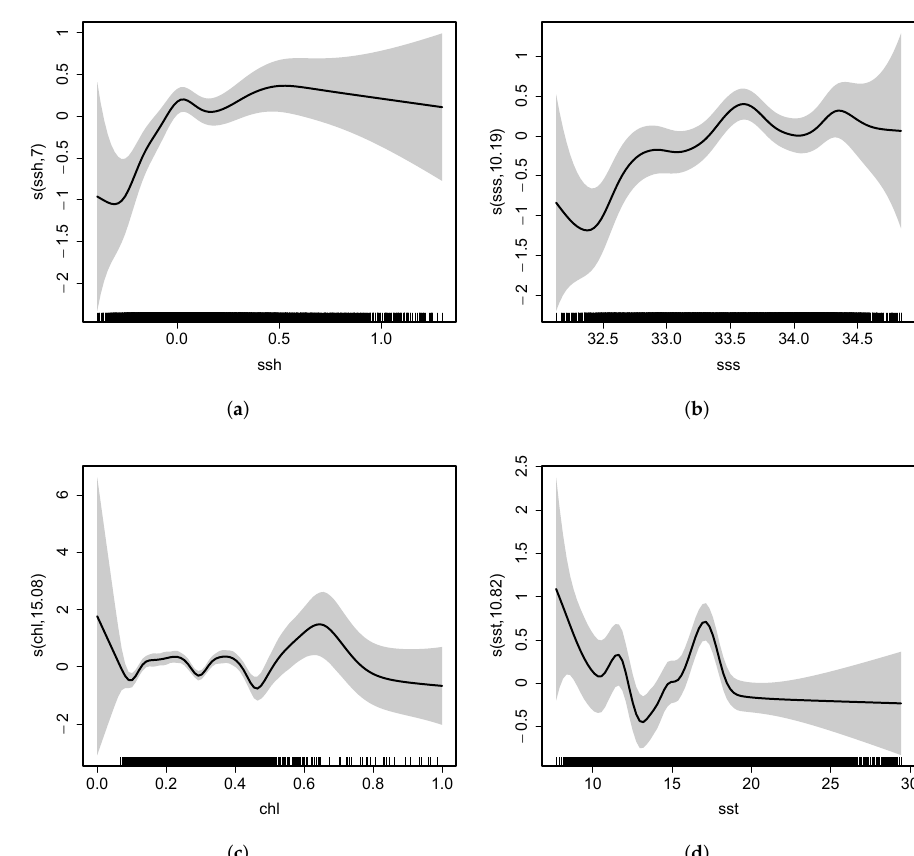
Figure 13. ( a ) The plan of the impacts of latitude and longitude on fishing effort. ( b ) The three- dimensional diagram of the impacts of latitude and longitude on fishing effort.